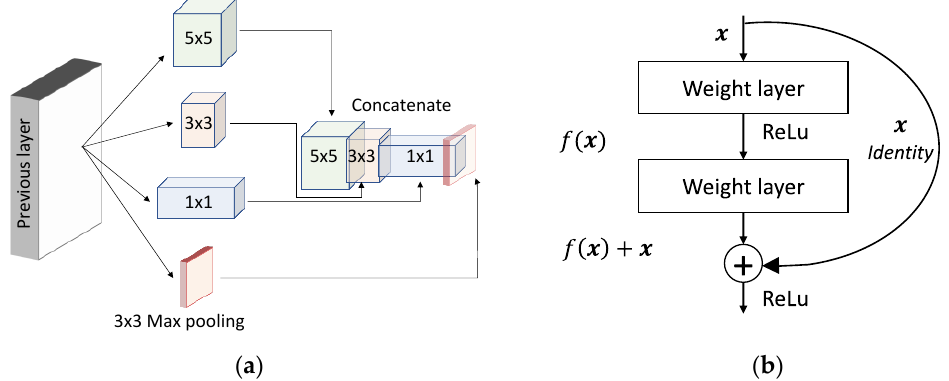
Figure 5. ( a ) The intuition behind the inception (V1) module in GoogLeNet. Screening local clusters with 1 × 1 convolutional operations, screening spread-out clusters with 3 × 3, screening even more spread-out clusters with 5 × 5 convolutional operations, and finally conceiving the inception module by concatenating ( b ) residual building block in ResNet.